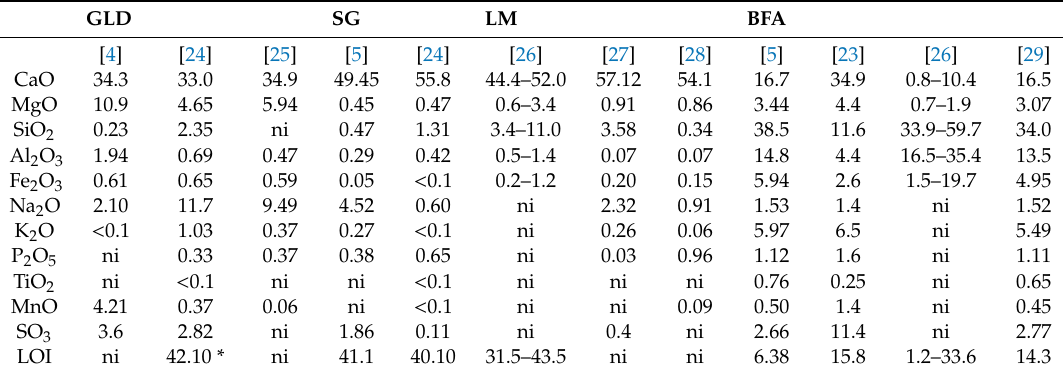
Table 2. Chemical composition of green liquor dregs (GLD), slaker grits (SG), lime mud (LM), and boiler fly ash (BFA) determined by XRF (wt %). GLD